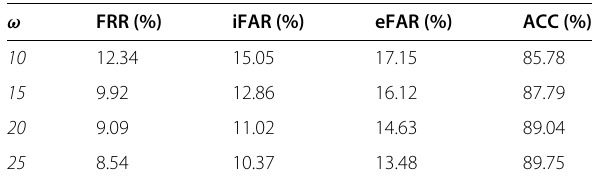
Table 6 The effects of the length of keystroke sequences ω on classifiers